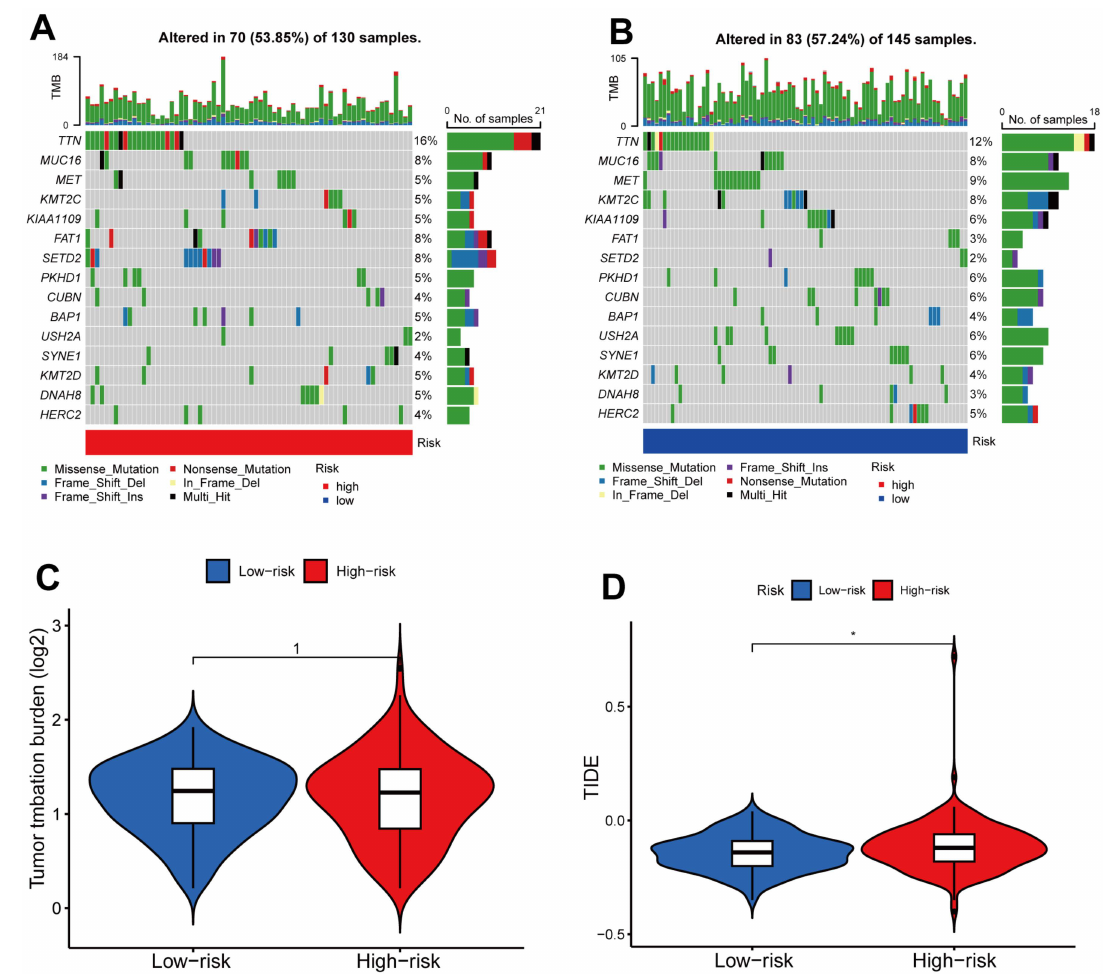
Figure 7. Tumor Mutational Burden (TMB) and Tumor Immune Dysfunction and Exclusion (TIDE) analysis. ( A ) The waterfall plot showed the TMB of 15 genes in high-risk set. ( B ) The waterfall plot showed the TMB for 15 genes in the low-risk set. ( C ) Analysis of the difference for TMB between low- and high-risk patients. ( D ) TIDE analysis for low- and high-risk sets. *, p <